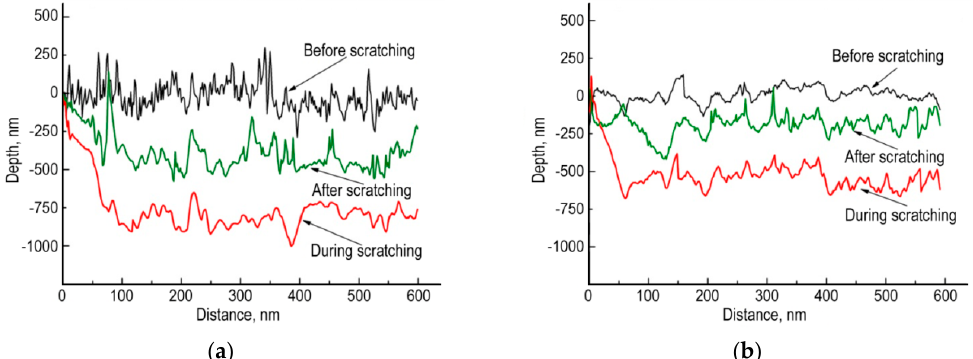
Figure 5. Surface profiles in Ti-6Al-4V samples 1 ( a ) and 2 ( b ) before, during and after scratching with an applied load of 200 mN.